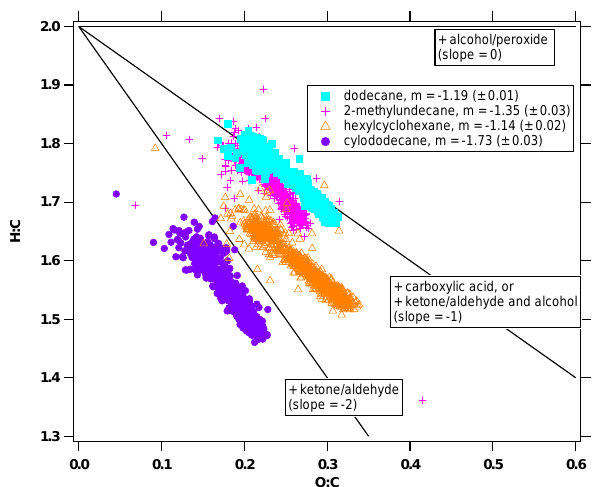
Fig. 11. Van Krevelen diagram for low-NO x photooxidation of n -dodecane, 2-methylundecane, hexylcyclohexane, and cyclodode-